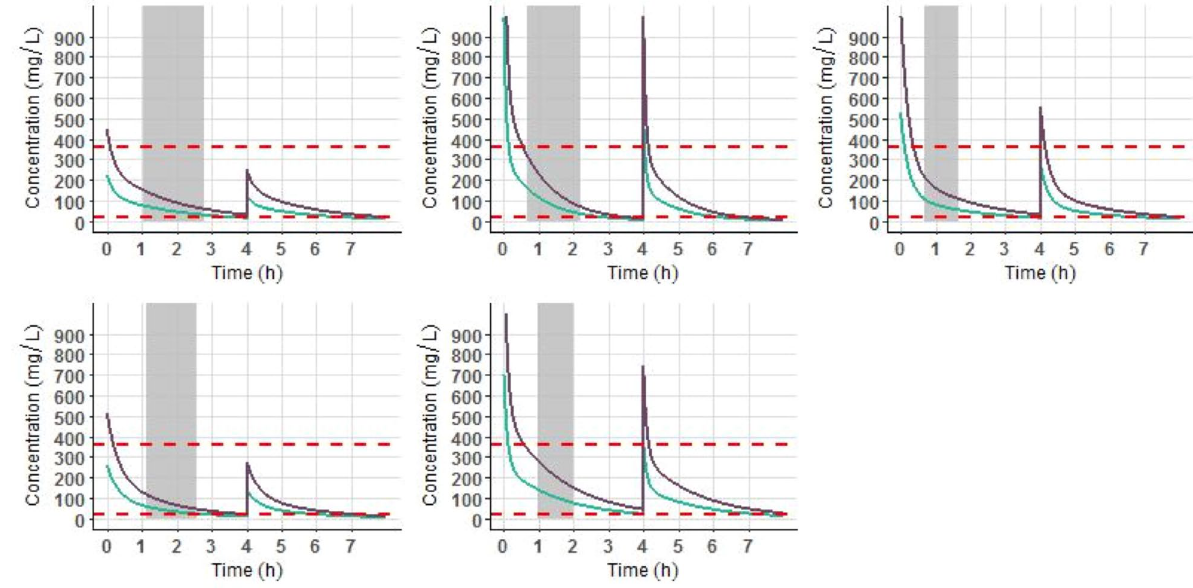
Figure 5. Simulations of the concentration–time course of cefazolin for the five patients included in the study with BMI > 35 kg/m 2 and total body weight > 100 kg after a 4000 mg bolus followed by a 2000 mg at 4 h (purple line) and after a 2000 mg bolus followed by a 1000 mg at 4 h (green line). The red dashed lines correspond to the 20 and 360 mg/litre concentration thresholds. Grey stripe represents to the surgery duration. Simulations